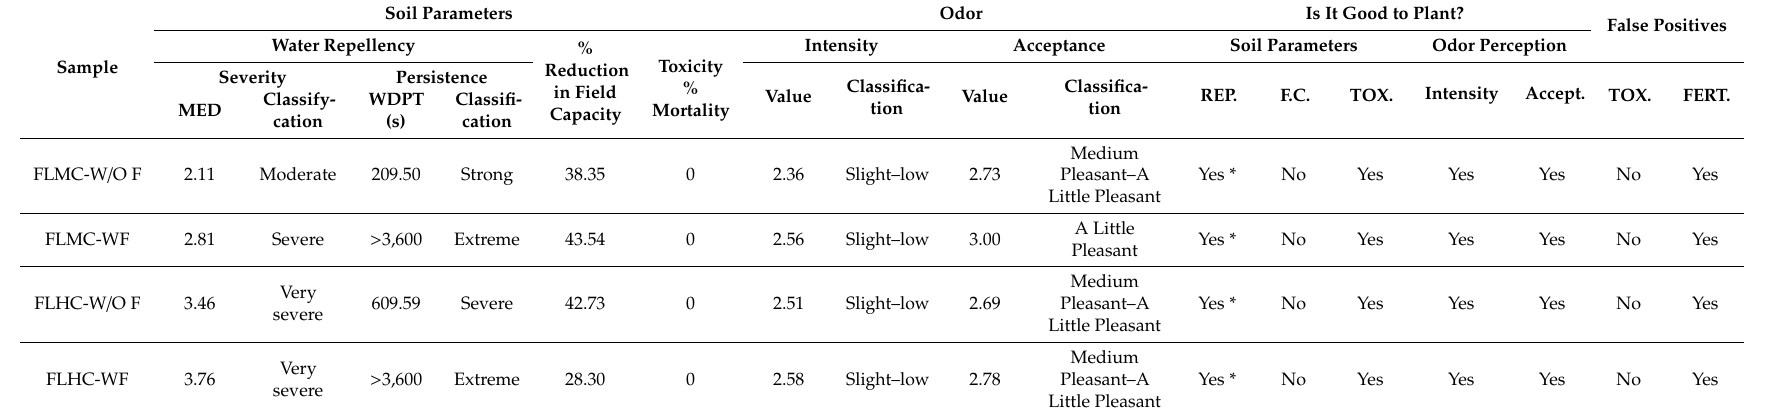
False Positives